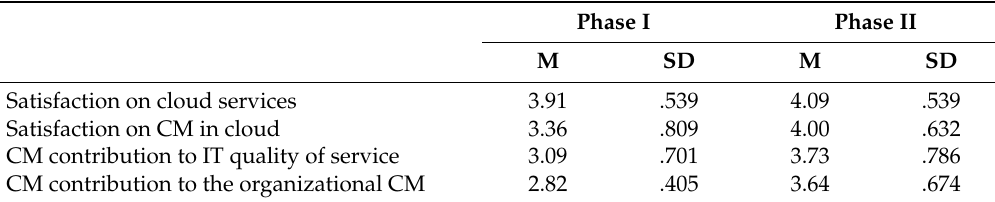
Table 3. Descriptive statistics on compliance evaluation sheet. Case Study